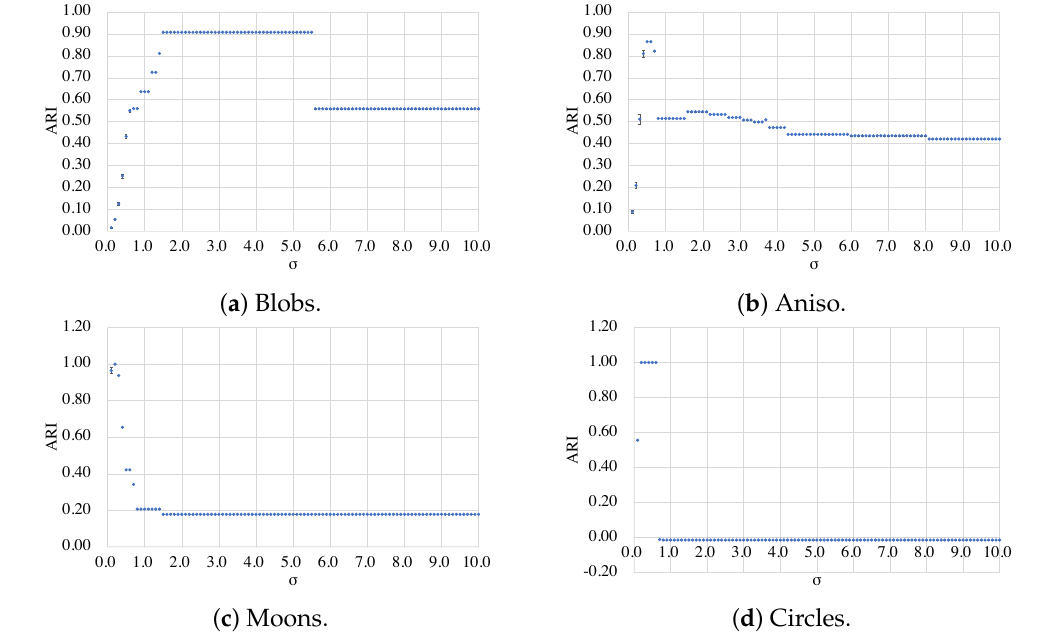
Figure 5. ARI of combinatorial clustering using kernel method when σ is